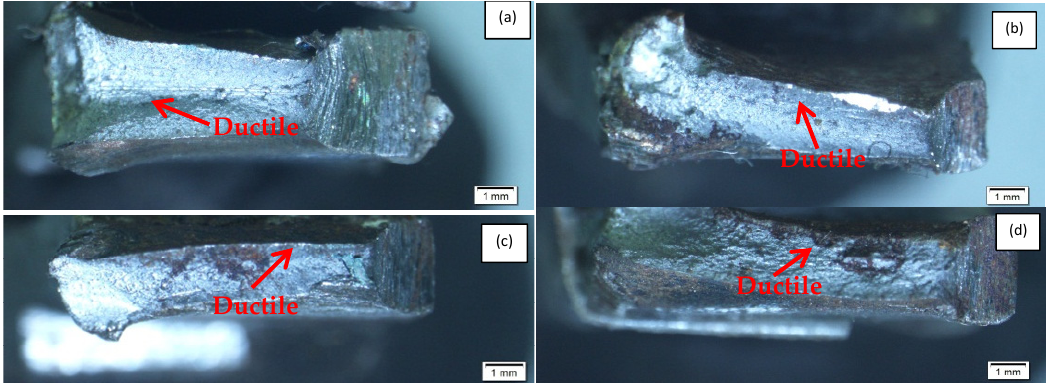
Figure 10. Fracture identified in the impact test on specimens welded under the following conditions: ( a ) air, ( b ) flowless underwater, ( c ) non-uniform flow with a bulkhead, ( d ) non-uniform flow without a bulkhead.